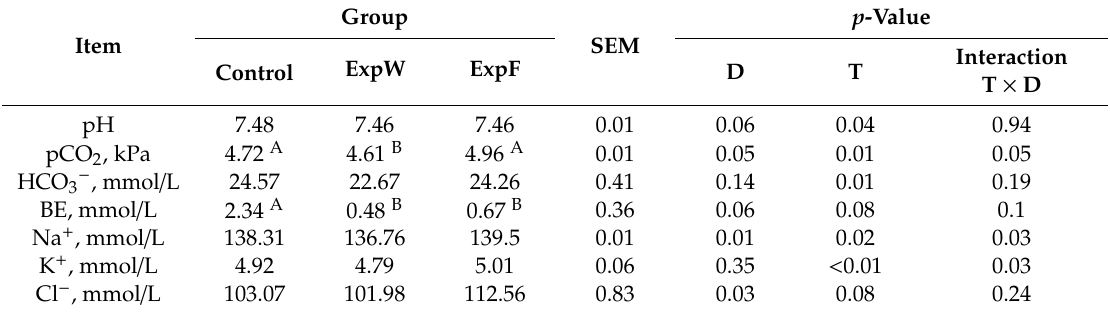
Table 5. Mean values of biochemical blood parameters in rabbit blood, TAS, and GPx